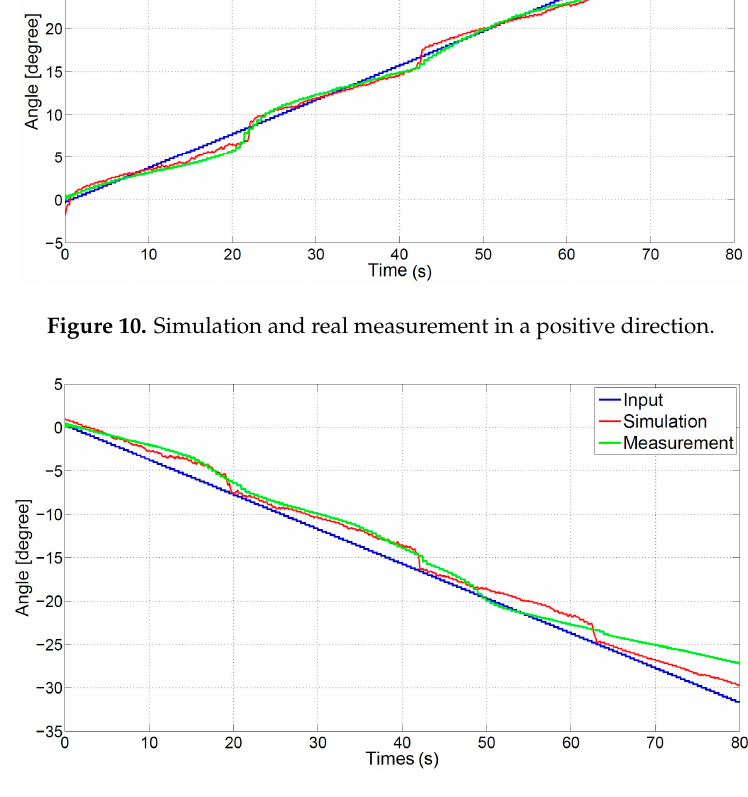
Figure 11. Simulation and real measurement in a negative direction.